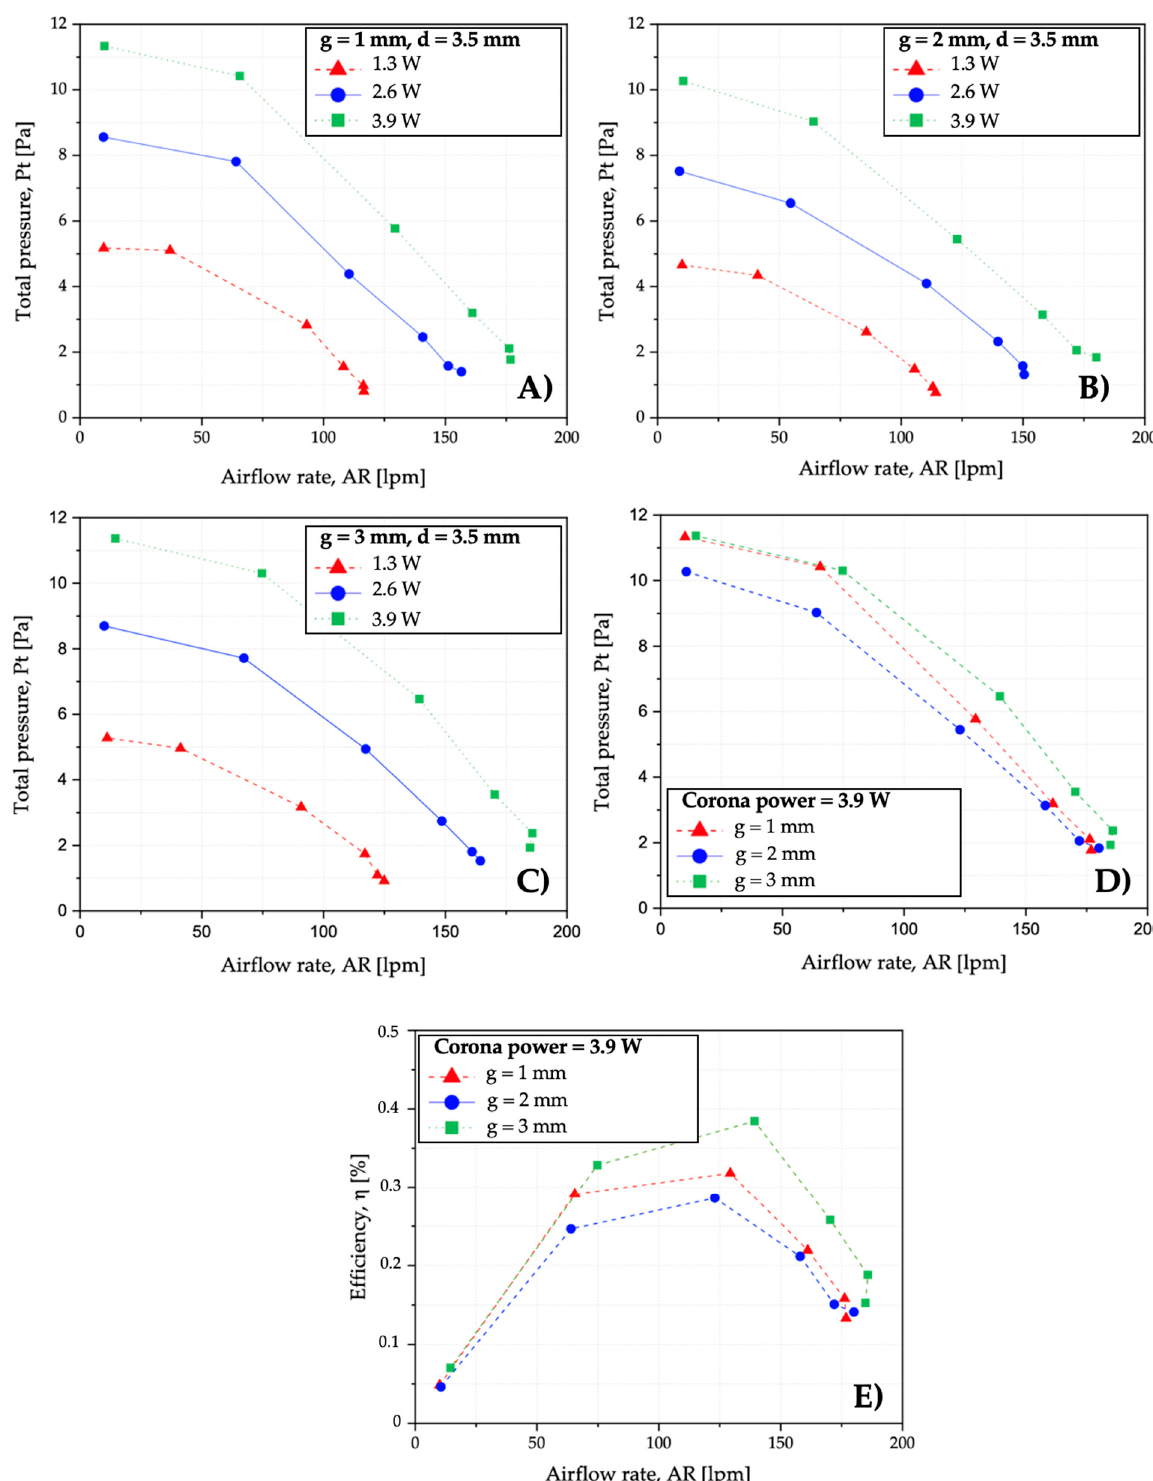
Figure 12. Evaluation of the pressure—the airflow rate for best performance device, considering a filament of 50 μ m, and several electrical powers: ( A ) gap = 1 mm, ( B ) gap = 2 mm, ( C ) gap = 3 mm. In graphs ( D , E ), the diverse gaps and efficiency with respect to a power of 3.9 W were analyzed, respectively.